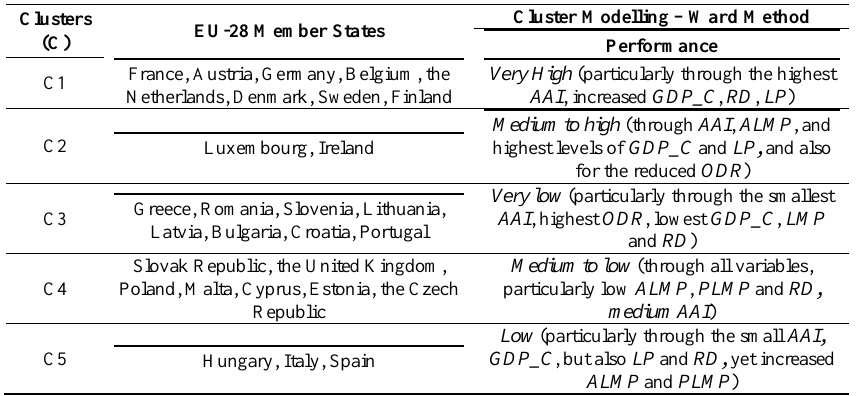
Table 2. Clusters results associated with the impact of the AAI, labour productivity, labour market policies and R&D activities upon the GDP per